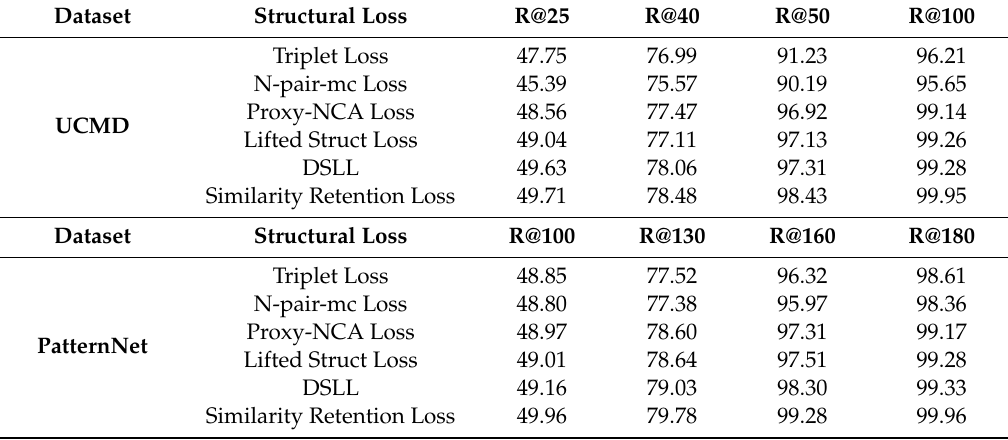
Table 2. The evaluation results of R@K on the PatternNet and UCMD database comparing with the other structure loss methods.